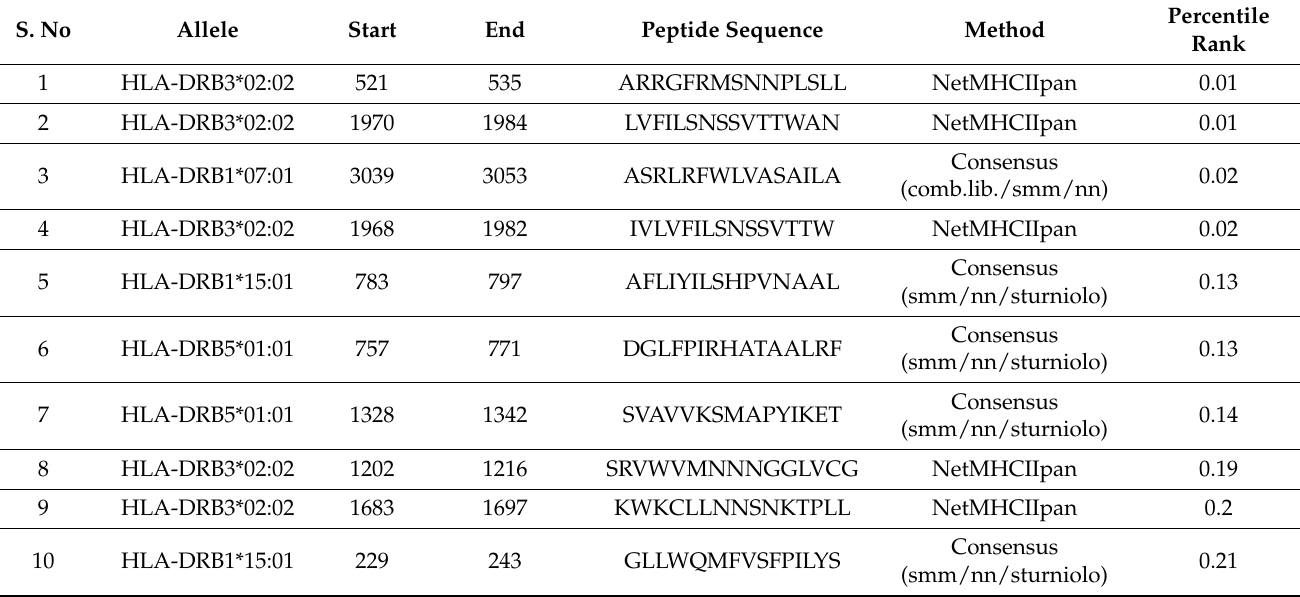
Table 2. Helper T-cell epitopes for selected proteins of human Pegivirus using the IEDB MHC-II module. S. No